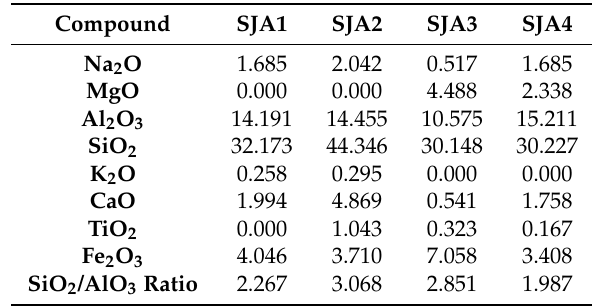
Figure 1. X-ray diffraction (XRD) patterns of soil samples. K = Kaolinite–Al 2 Si 2 O 5 (OH) 4 , Q = Quartz–SiO 2 , A = Albite–Na(AlSi 3 O 8 ). Table 1. Chemical composition of soil samples.